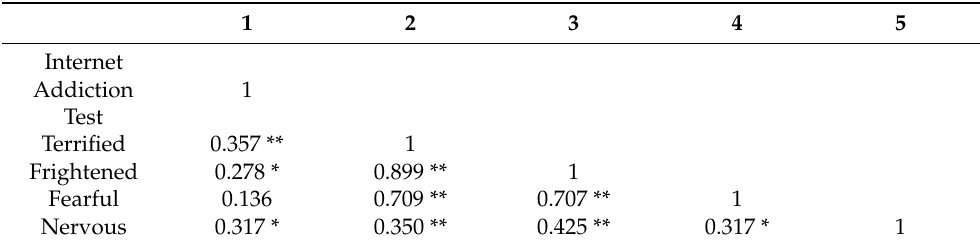
Table 3. Association between Internet dependency and the dysfunctional negative emotions terrified, frightened, and nervous.